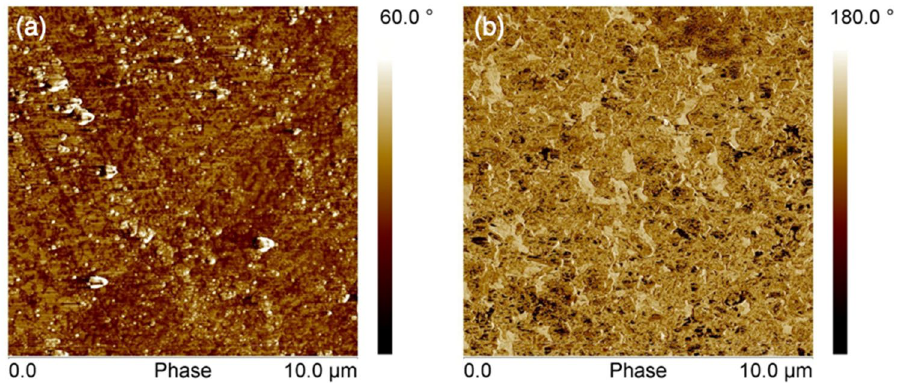
Figure 9. Tapping mode AFM phase images in 10 × 10 µm scan areas: ( a ) PET and ( b )